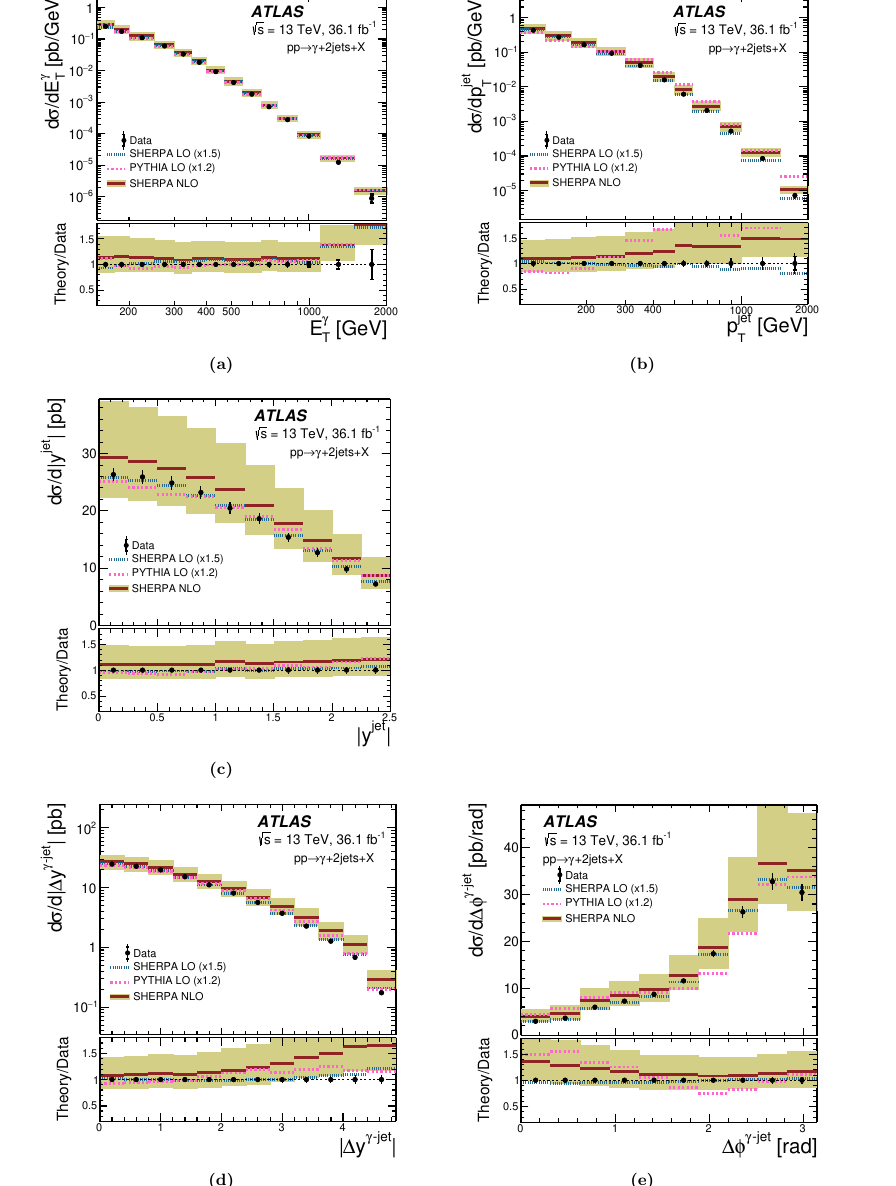
Figure 4 . Measured cross sections for isolated-photon plus two-jet production (dots) as functions of (a) E (cid:13) , (b) p jet , (c) j y jet j , (d) j (cid:1) y (cid:13) {jet j and (e) (cid:1) (cid:30) (cid:13) {jet for the total phase space. The NLO T T QCD predictions from Sherpa (solid lines) based on the NNPDF3.0 PDFs are also shown. The tree-level plus parton-shower predictions from LO Sherpa (dotted lines) and Pythia (dashed lines) normalised to the integrated measured cross section (using the factors indicated in parentheses) are also shown. The bottom part of each (cid:12)gure shows the ratio of the predictions to the measured cross section. The inner (outer) error bars represent the statistical uncertainties (the statistical and systematic uncertainties added in quadrature) and the (cid:12)lled bands represent the theoretical uncertainty of the NLO QCD predictions. For most of the points, the inner and outer error bars are smaller than the marker size and, thus, not visible. The visible thin error bars represent the outer error bars.